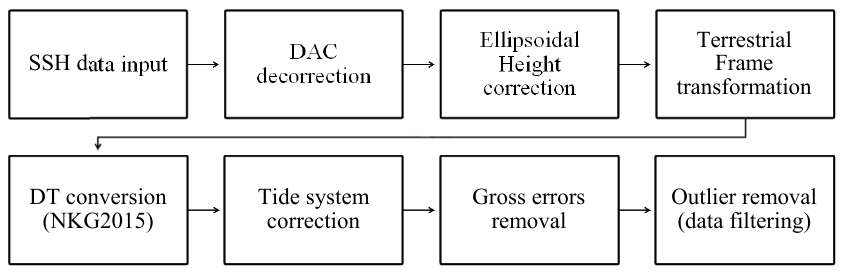
Figure 8. SA data preprocessing steps diagram including data filtering, harmonization, and corrections.